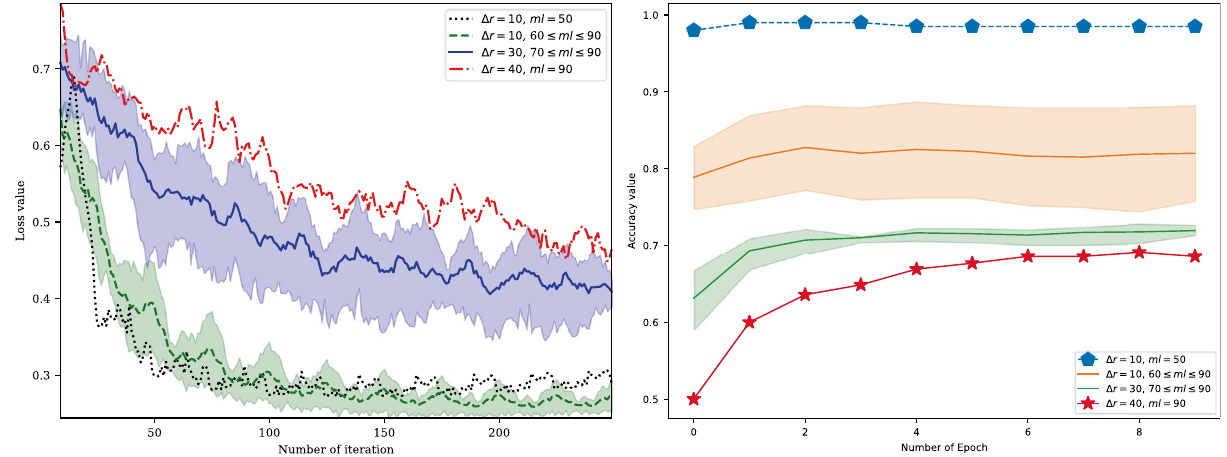
Figure 4. Training loss and validation accuracy values. Using the SARD datasets, we train QDENN models at different data intervals, with the batch size set to 32. The SGD optimizer is used as the parameter optimizer. To make the loss curve smoother, we process it based on the average value of a rolling window when drawing the curve, and the rolling window size is set to 3. Since the data intervals ( (cid:31) r is 30 and 40) are obtained by merging the subintervals, more iterations are required for training. In this study, we plot the training loss with 250 fixed iterations. Meanwhile, we plot the validation accuracy with the validation datasets under 10